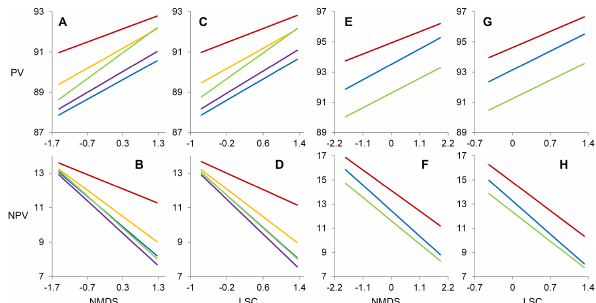
Figure 2. Relationship between plant species composition, soil cation concentrations, and productivity at sites in northern Peru. (A) to (H) Linear regressions of the log-transformed sum of Ca, Mg, Na, and K concentrations (LSC) or nonmetric multidimensional scaling (NMDS) values against PV or NPV for Pastaza–Tigre sites ( A to D ) or Curaray sites ( E to H ). Each regression line represents a single Landsat image date, and lines are color coded by date. Image dates and correlation coefficients are provided in Table 1. P < 0 . 001 for all